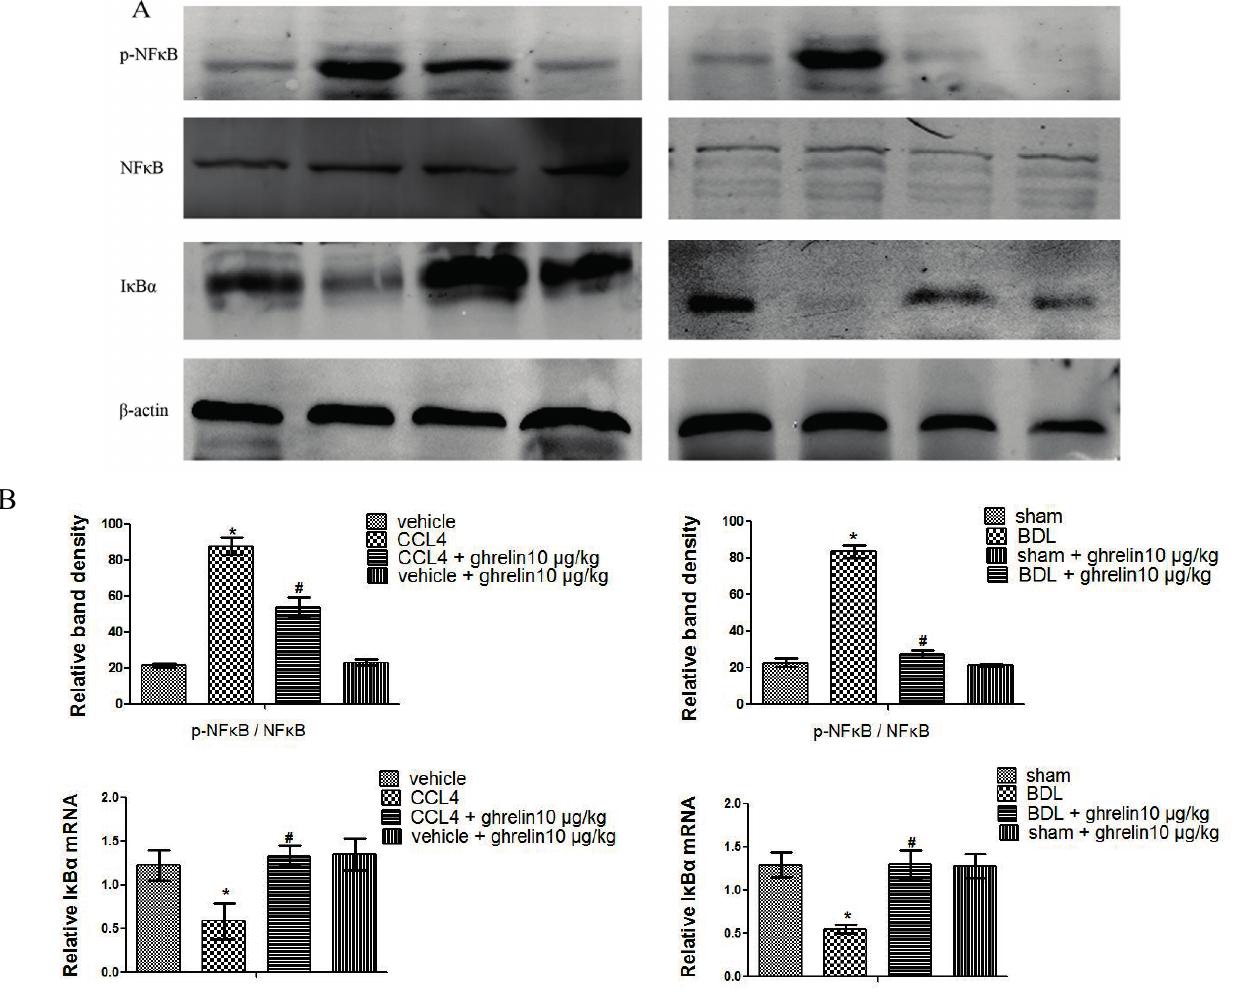
Figure 6. Ghrelin may be associated with NF- κ B signaling pathway inhibition. ( A ) Western blot analysis of p-NF- κ B, NF- κ B, and I κ B α in CCl 4 - and BDL-induced fibrotic liver tissues; and ( B ) Relative band density of p-NF- κ B/NF- κ B and real-time PCR evaluation of I κ B α in both CCl 4 - and BDL-induced fibrotic liver tissues. ( n = 7, * p < 0.05 for the CCl 4 or BDL group vs. the vehicle or sham group, # p < 0.05 for the ghrelin + CCl 4 or BDL group vs. the CCl 4 or BDL